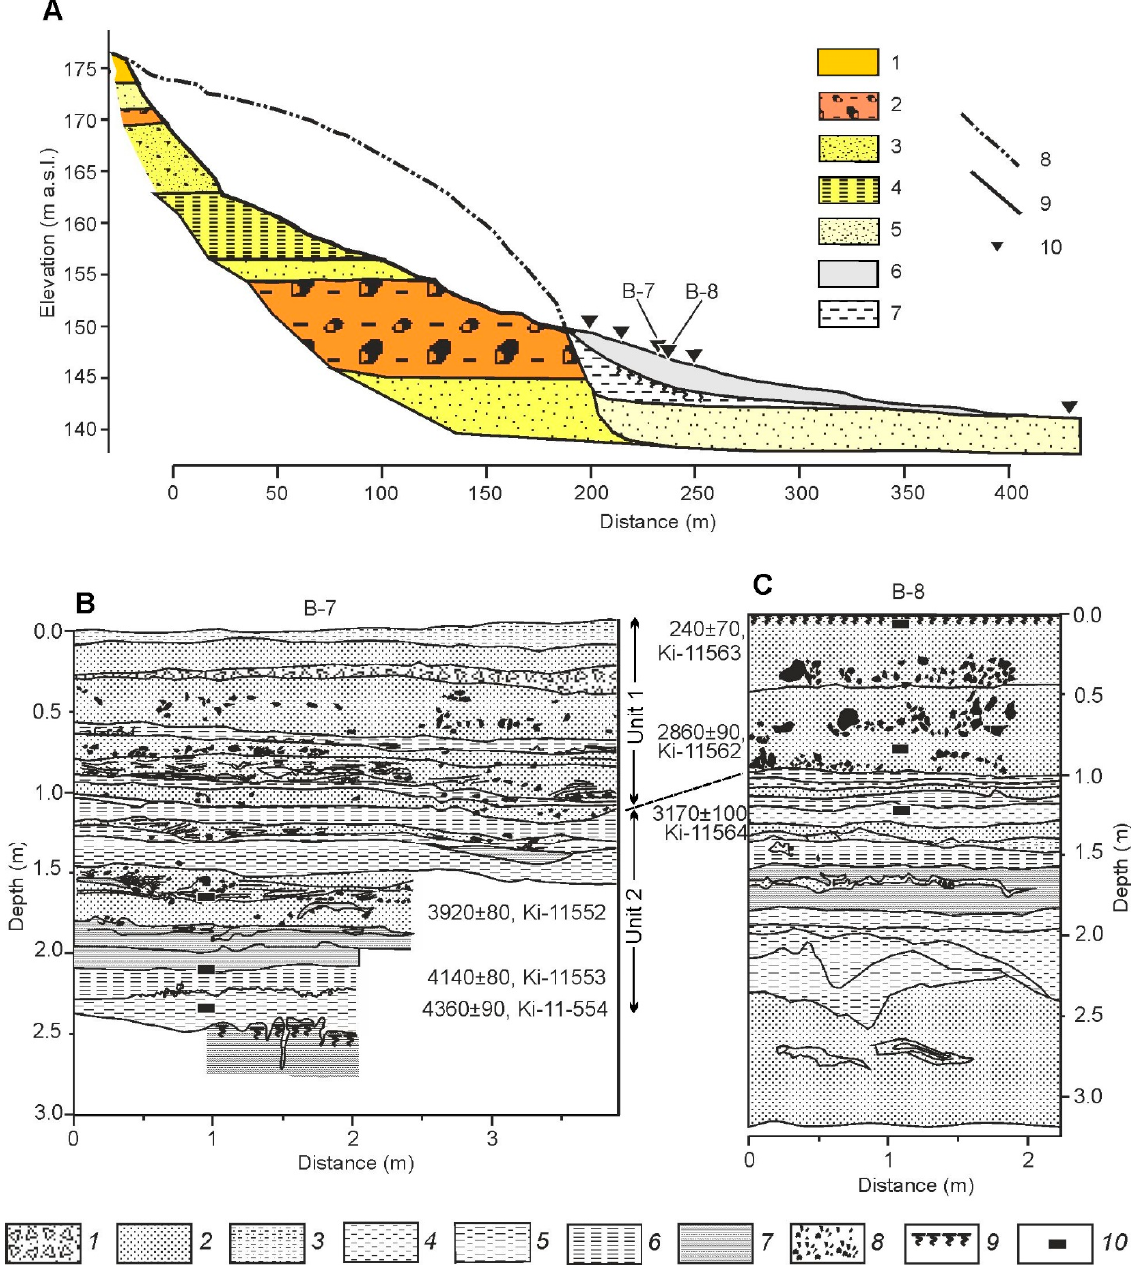
Figure 13. The longitudinal profile of the Volchiy Gully and the structure of its fan. Keys for the